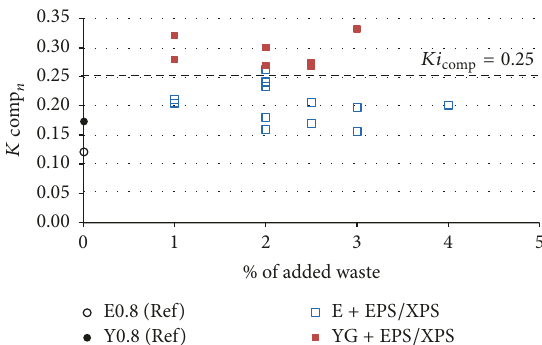
Figure5:Lighteningcoefficientsofthecompoundstestedaccording to compressive strength.